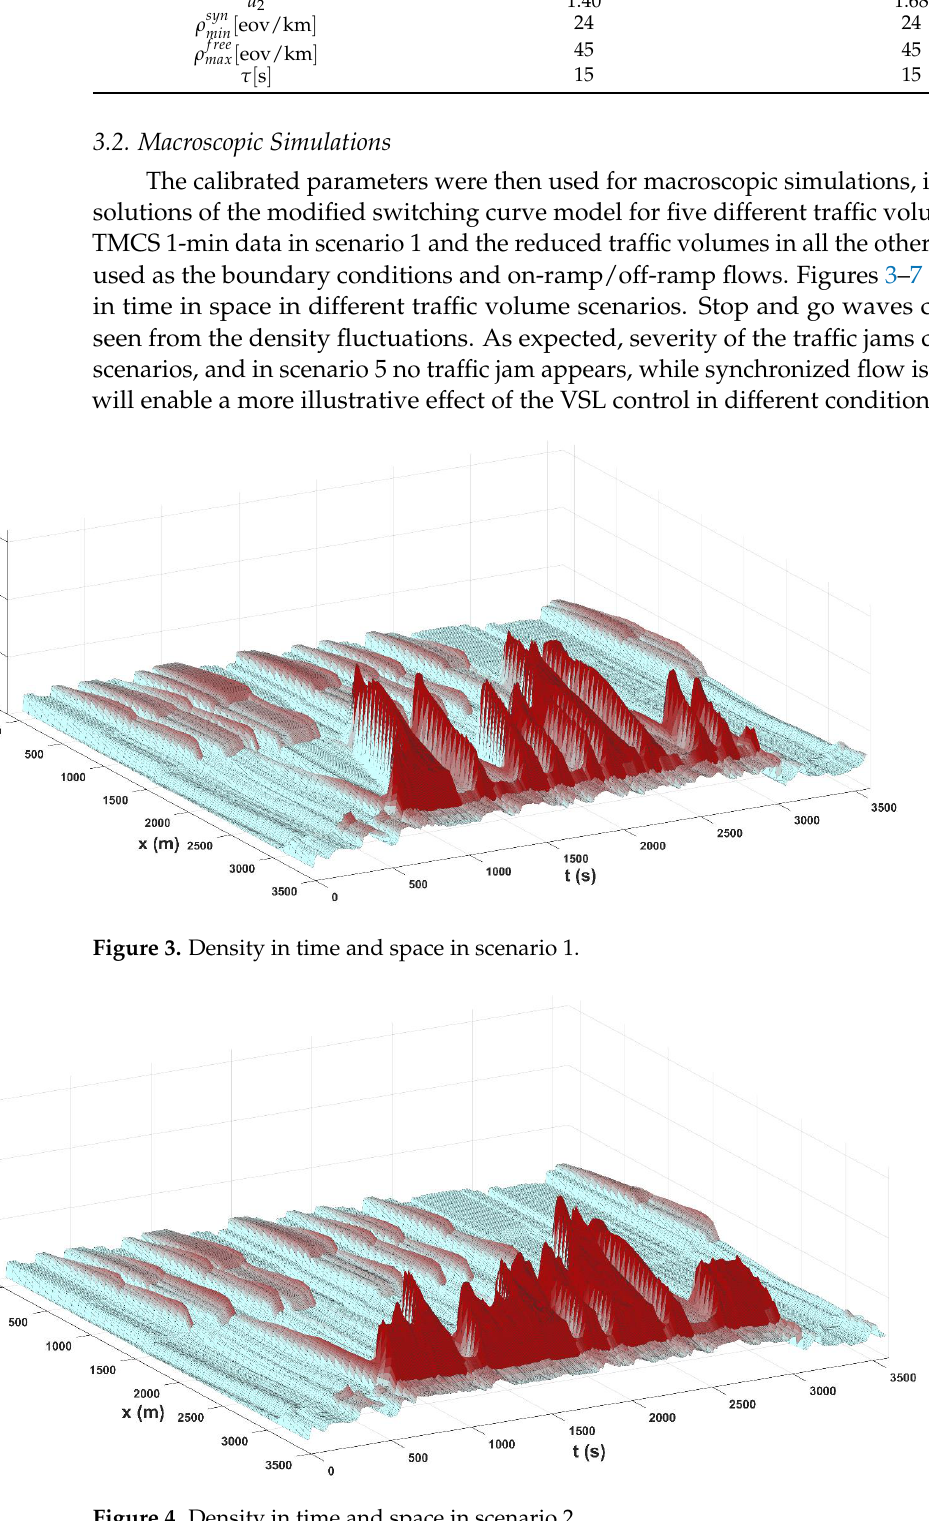
Figure 5. Density in time and space in scenario 3.